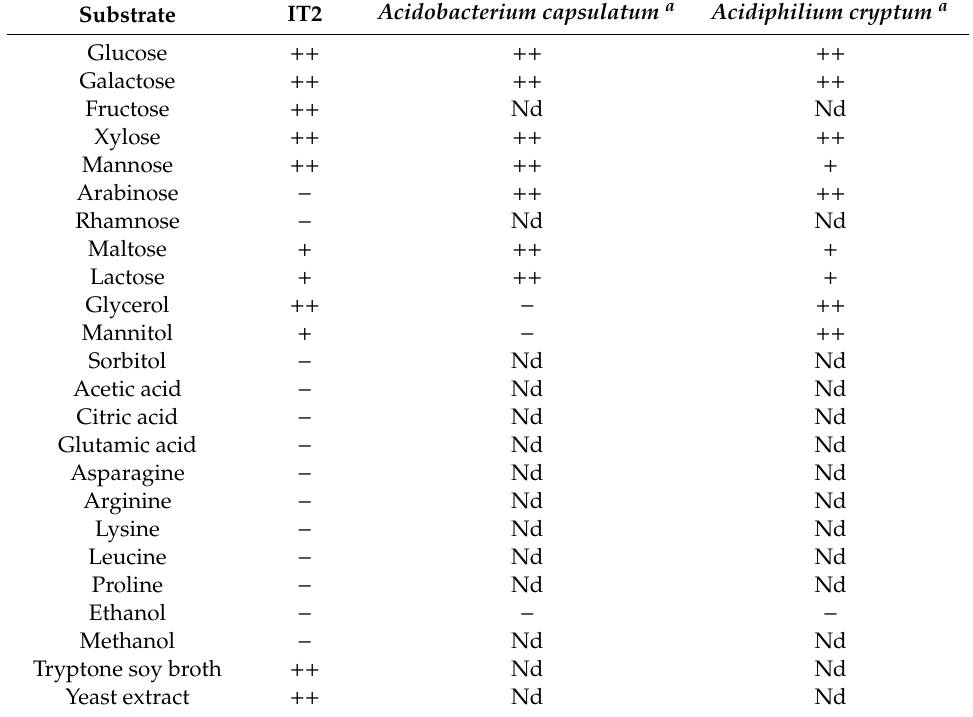
Table 1. Comparison of organic substrates utilized by isolate IT2, and Acidobacterium capsulatum and Acidiphilium cryptum also found in mine tailings. ++ , strong growth; + , weak growth; -, no growth. Key: ( ++ ) OD 600 values > 0.6; ( + ) OD 600 values between 0.1 and 0.6; ( − ) OD 600 < 0.1.